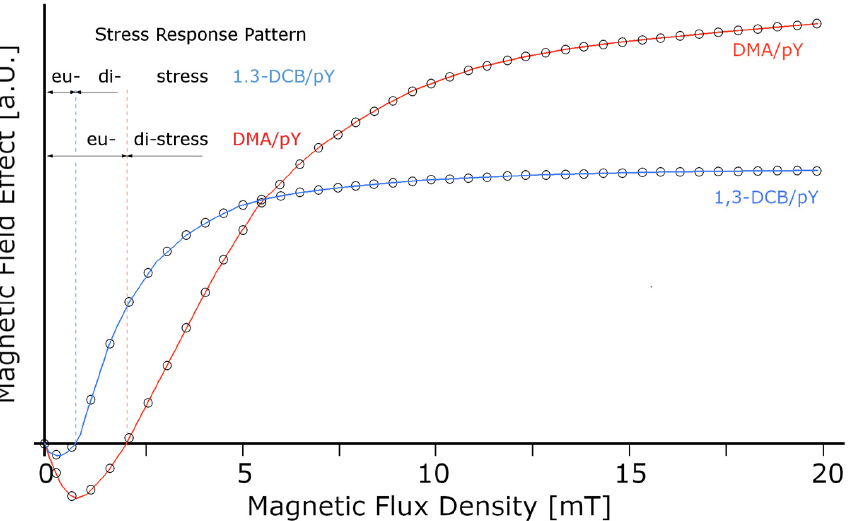
Figure A1. Curves of the modelled magnetic field effects of exciplex systems consisting of pyrene and isomers of dicyanobenzene (1,3- dicyano-benzene (DCB) or dimethyl-aniline (DMA)) (redrawn and modified after [60]). Superimposed, the eustress and the corresponding distress response regimes indicating that weak field stimuli promote, whereas strong field stimuli inhibit.